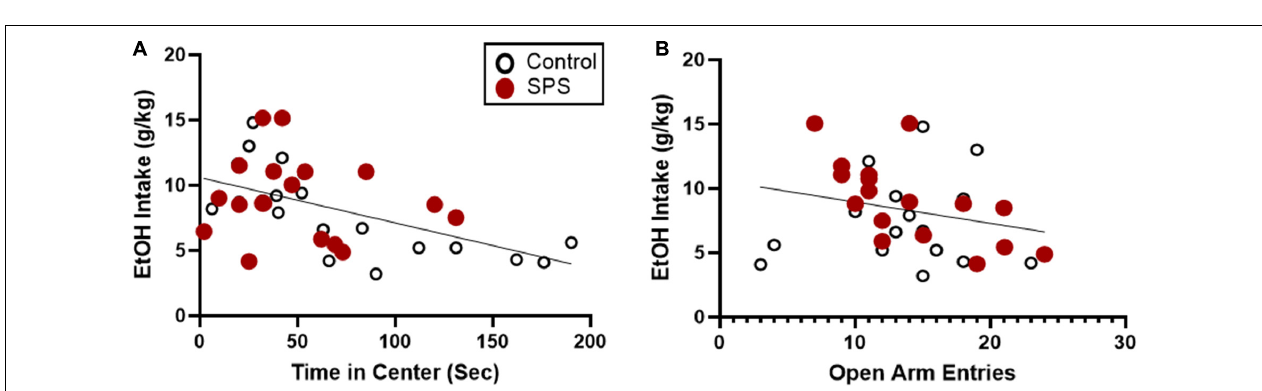
FIGURE 4 | Ethanol consumption (g/kg/24 h session) for traumatic-stress exposed (SPS, N = 17) and non-stressed control rats ( N = 16) is shown across 24 drinking sessions. There was a significant main effect of session ( P < 0 . 0001), and a significant interaction between session and control/SPS main effects ( P < 0.05). Post hoc tests revealed a significant difference in ethanol consumed between SPS and control rats during session 20 (* P < 0.05). Data are expressed as means + SEMs.